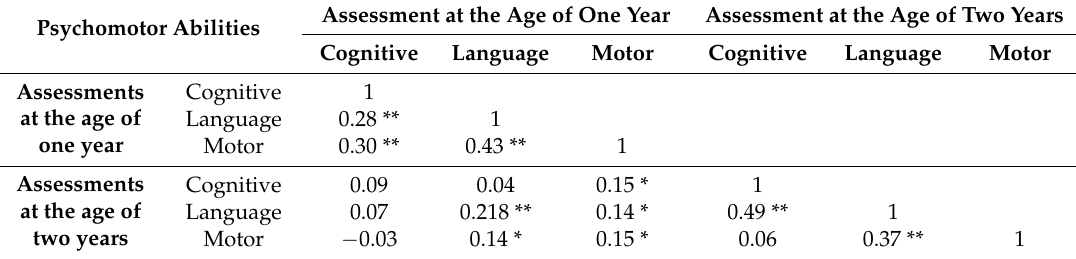
Table 1. Spearman correlation between the Bayley test results assessments at one and two years of age. Assessment at the Age of One Year Assessment at the Age of Two Years Psychomotor Abilities Cognitive Language Motor Cognitive Language